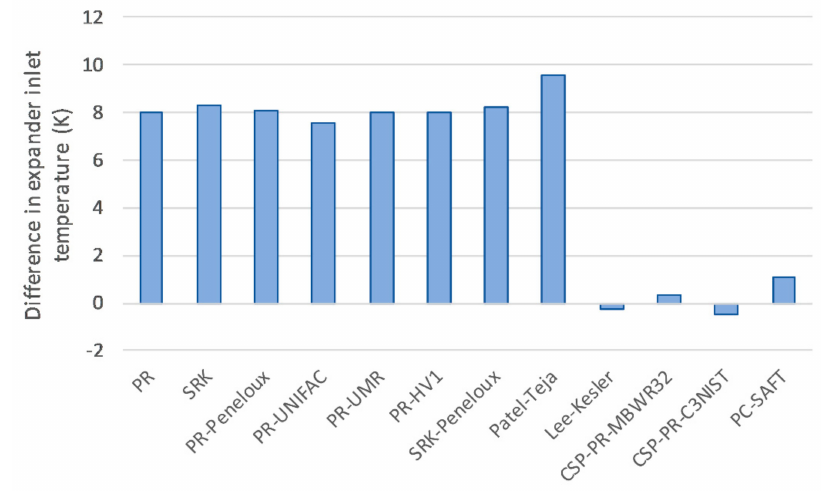
Figure 3. Di ff erence in optimized expander inlet temperature relative to GERG.